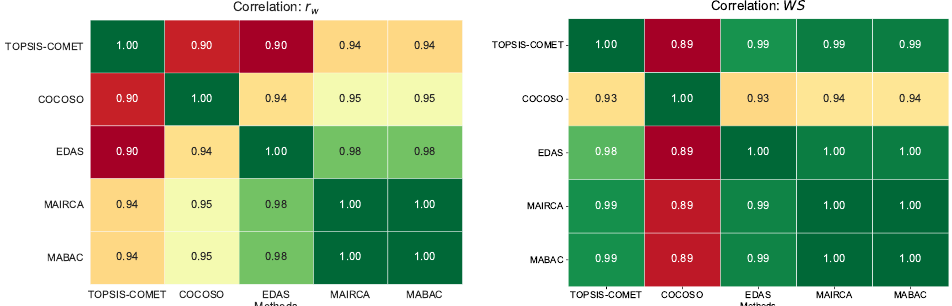
Figure 2. Visualization of rankings correlation coefficients r w and WS for each pair of MCDM method for a small set of